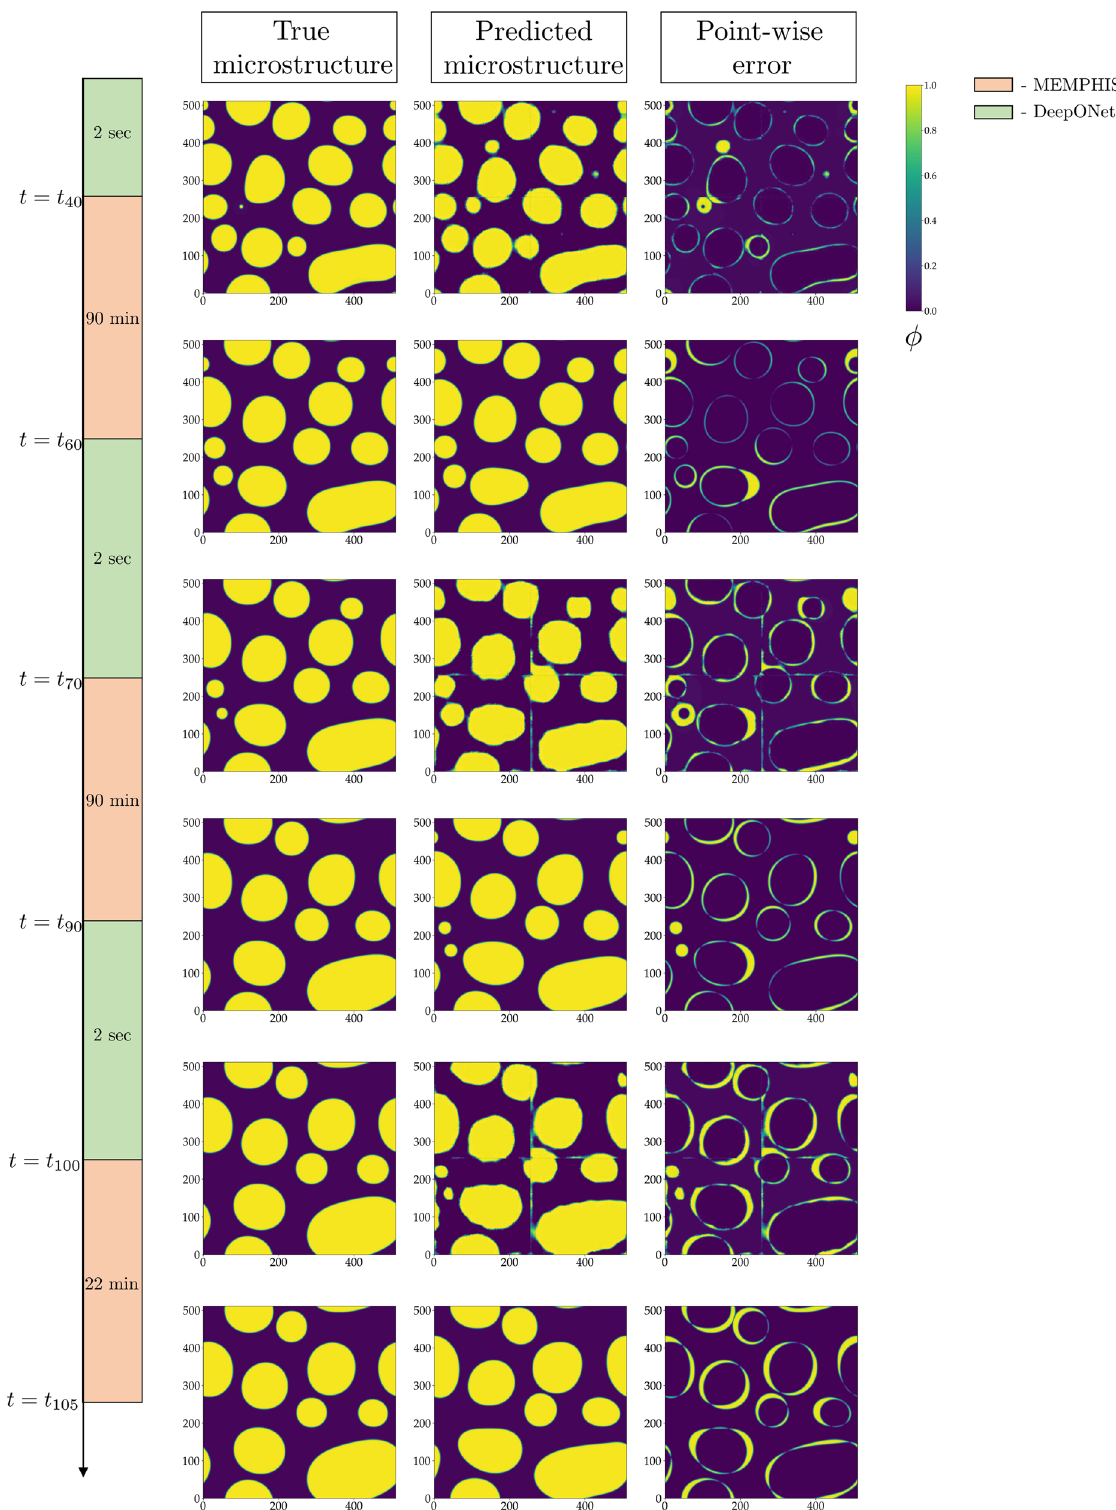
Fig. 6 Schematic of our hybrid approach for integrating DeepONet with the numerical solver MEMPHIS to accelerate phase- fi eld predictions. The computational time corresponding to the autoencoder--DeepONet model and the MEMPHIS solver for one realization in the training dataset is reported in this fi gure. The error is shown on the third